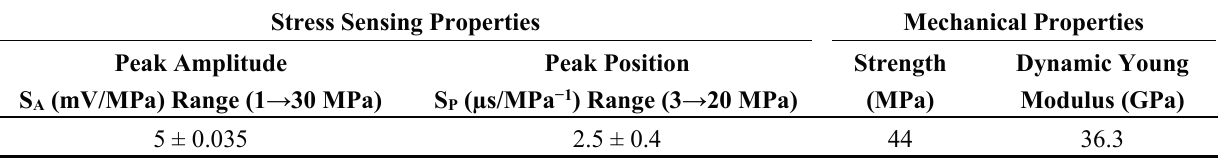
Table 2. Stress sensing of MMCC sensor and mechanical